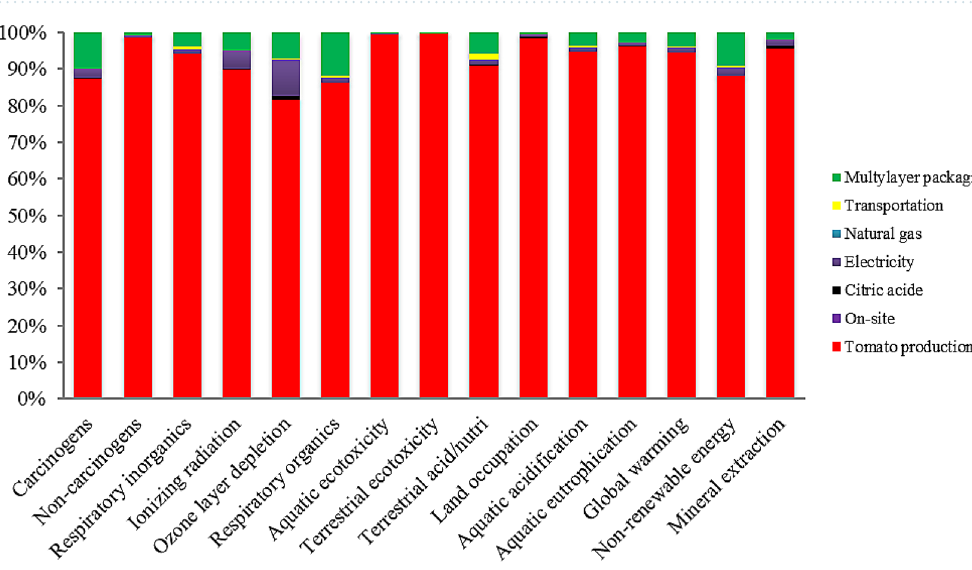
Figure 4. Inputs contribution to the environmental impact of tomato juice production upon ohmic